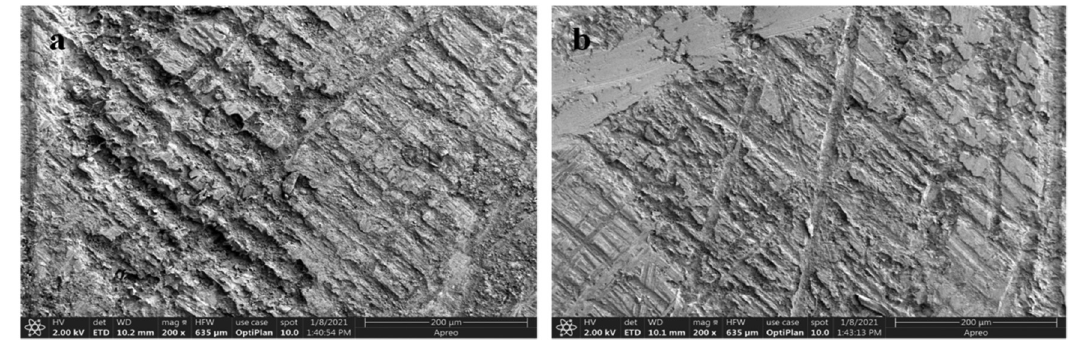
Figure 10: SEM image of peeling tinplate surface after 9 day immersion in 3.5 wt% NaCl solution: ( a ) AR - F and ( b ) 3% SiO 2 @AR - F.